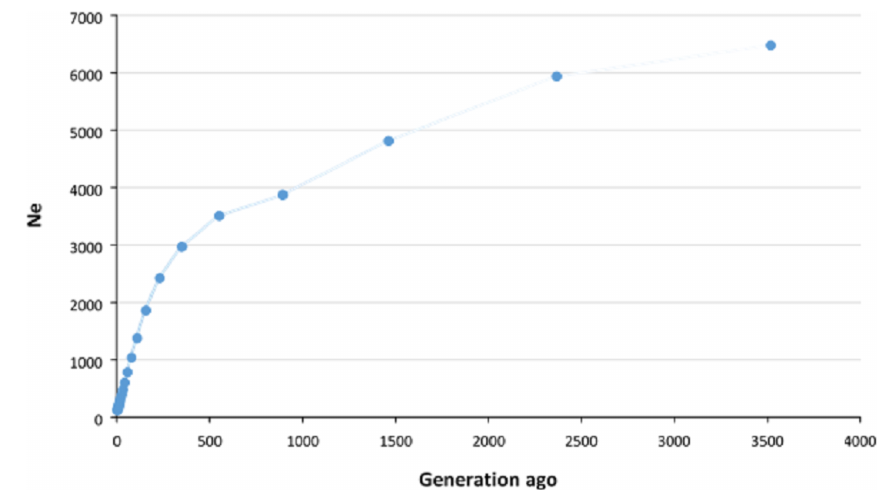
Figure 2. Estimation of effective population size ( N e ) of Zandi sheep using genome-wide linkage disequilibrium ( r 2 ) between SNPs. N e was estimated using average r 2 between markers at different distances by SNeP software. The N e in the past (approximately 3500 generations ago) was 6475, which decreased to 3000 approximately 500 generations ago and then continued to decrease more rapidly until recent generations. The N e of recent populations (up to five generations ago) was estimated to be